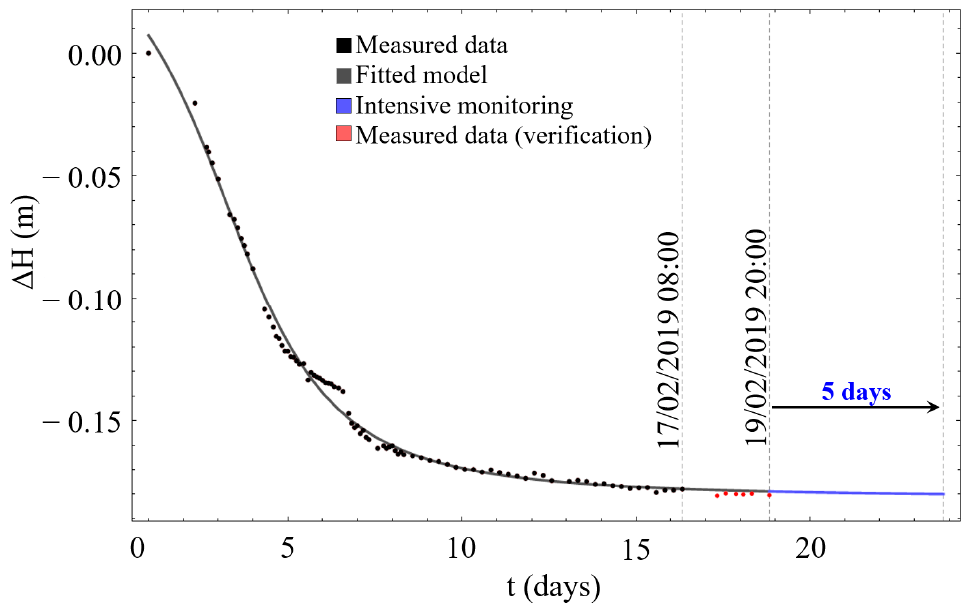
Figure 18. Third monitoring adjustment for point MG19. Minerals 2020 , 10 , x FOR PEER REVIEW